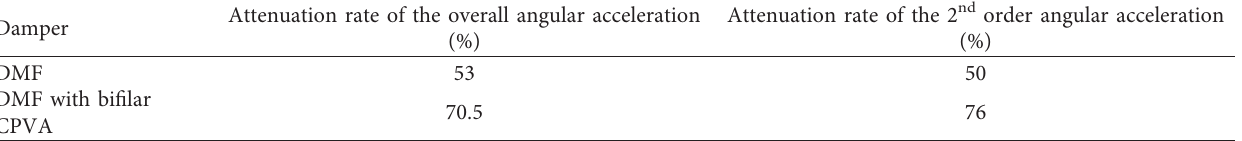
Table 10: Attenuation rate of the angular acceleration under the idling condition.